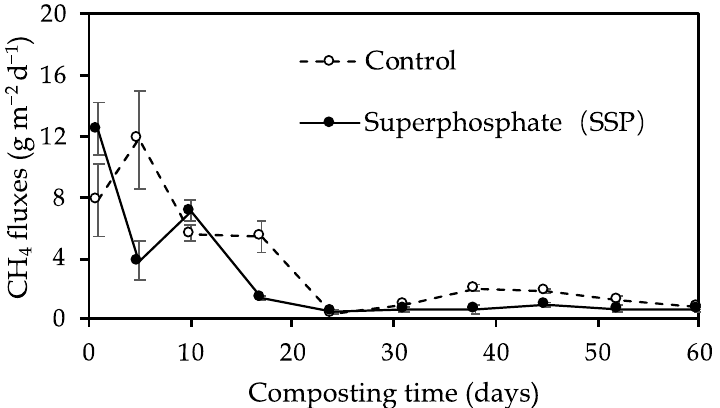
Figure 1. The dynamics of CH 4 fluxes during the composting progress. Error bars show a standard error of the mean of triplicate compost windrows.